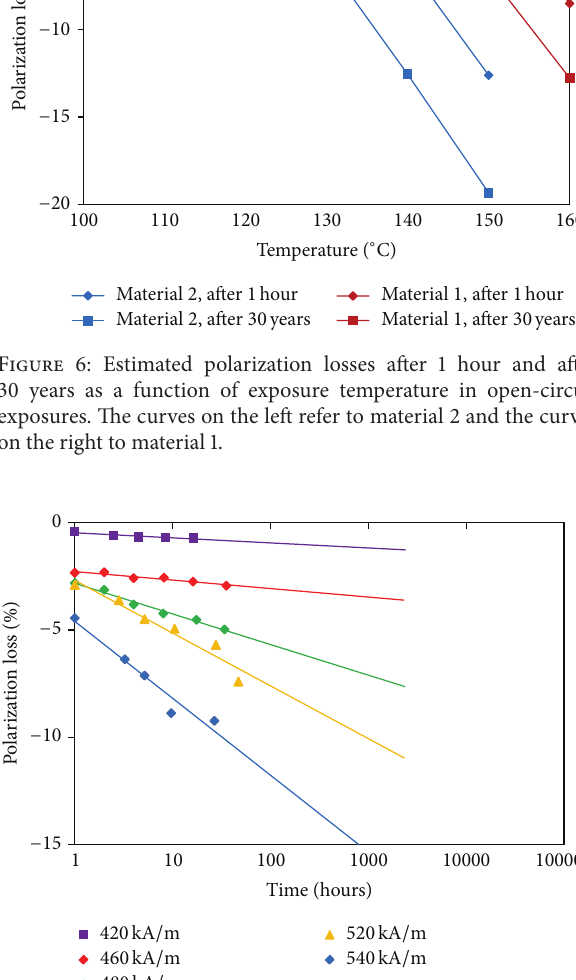
the samples exposed to 120 ∘ C. The variation of the initial loss in closed-circuit samples exposed to fields from 480 to 520 kA/m was only 0.9%